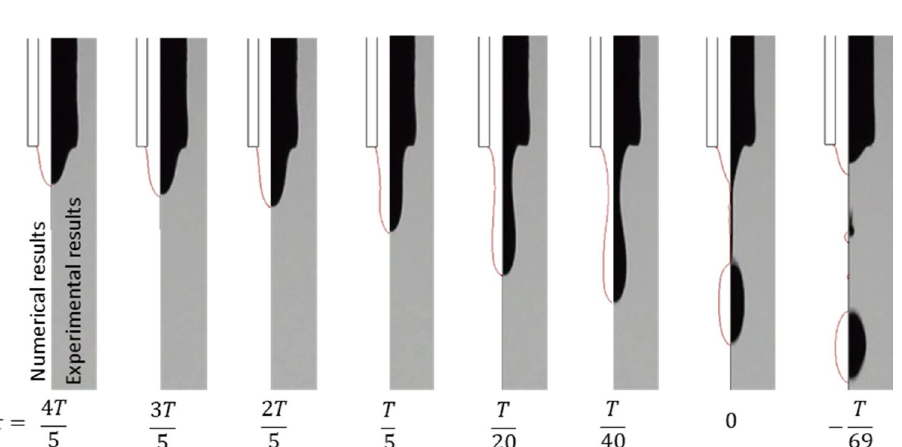
Figure 7. The process of ferrofluid droplet formation under a magnetic field obtained by numerical (left side) and experimental (right side) methods with Bo m = 380.9 and L = 8 mm. τ time until the droplet formation, which is expressed in terms of the time period (T) of droplet